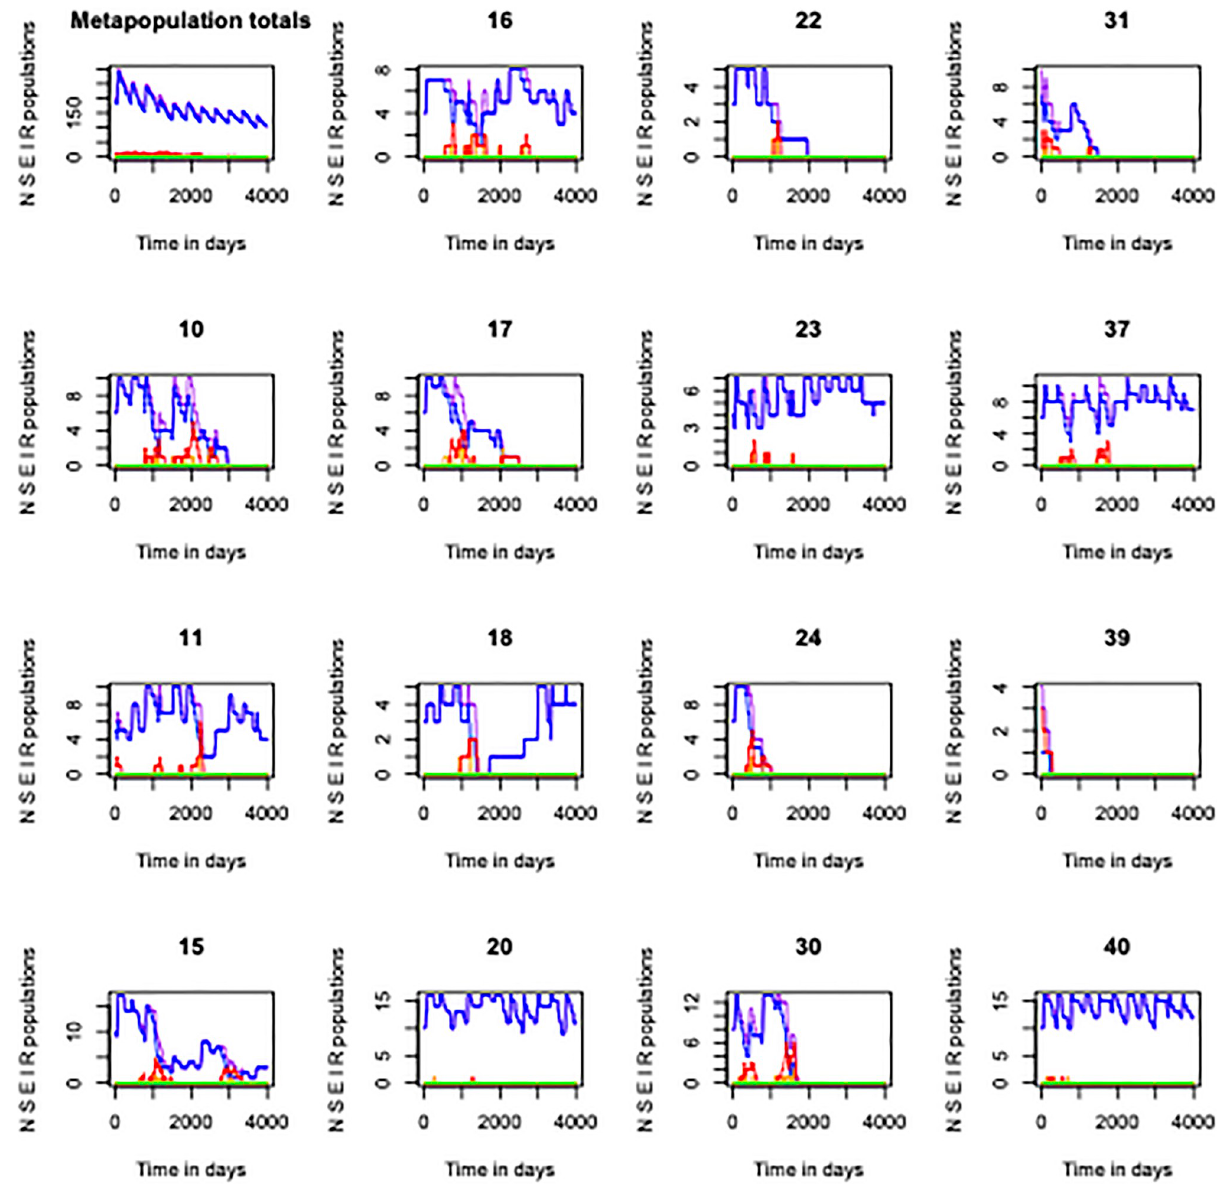
Fig 5. Examples of runs of simulation metaseir, which is called by seirshell. The figure plots overall metapopulation numbers and outcomes in 15 patches (excluding patches where local K = 0 and including diversity among the remaining patches with respect to K) to illustrate the types of results that can be obtained. N, S, E, I, R numbers are shown in purple, blue, orange, red, green respectively. This simulation run with β = 0.0015, a b = 0.6, m = 0.00005 and α = 0.001 led to an epidemic persistence time of 3350 days (9.2 years), and the kit fox population dropped to about half of its starting point. Both kit fox and parasite populations show metapopulation dynamics with local extinction and colonization, with the annual birth pulse evident in the metapopulation totals panel. Data were generated in R by the function call: > h = 49; fox49outmarch2 = seirshell(trials = 1,tmax = 4000,h = 49, beta = 0.0015, alphabeta = 0.6, EIbirth = F,BetaHwander = diag(0,h,h), seirscape = foxscape49, seirdem = foxseirdem49, seirrates = foxseirrates49, seirnaught = foxseirnaught49); animetaseir(fox49outmarch2$meanmfx,4,4, patchdisplay = c(10,11,15,16,17,18,20,22,23,24,30,31,37,39,40), deathtrace =